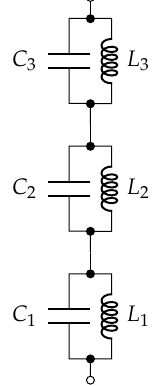
Figure 10. Triple tune